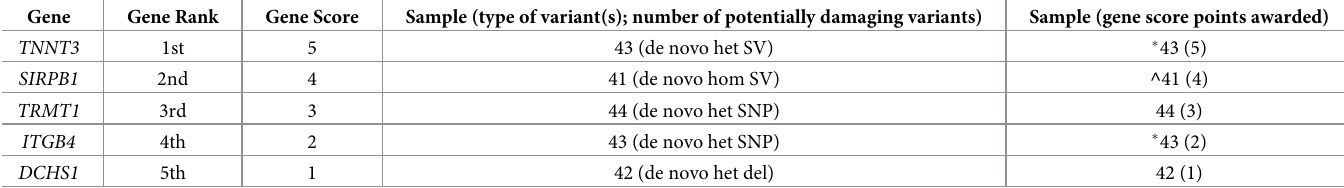
We ranked genes based on the average gene-disease connection and disease likelihood scores (S4 Table). The gene scores were equally divided among the samples when more than one sample shared a variant in that gene. “ � ” indicates the child predicted to have cancer and “ ^ ” indicates the actual child with cancer. Sample 43 had simple-heterozygous variants (either SNP or structural variant) in 2 of 5 genes and was predicted to have had Burkitt’s lymphoma based on having the highest individual score of 7. Abbreviations: het = simple heterozygous. hom = homozygous. del = deletion. SV = structural